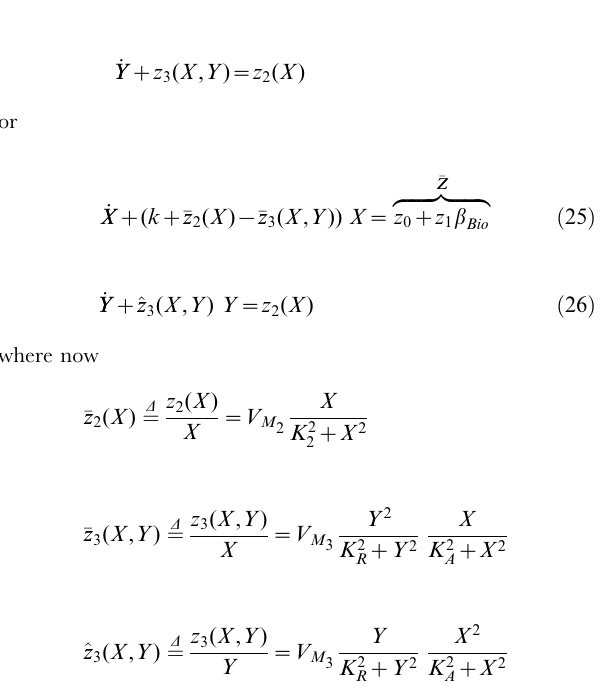
in a complete analogy.